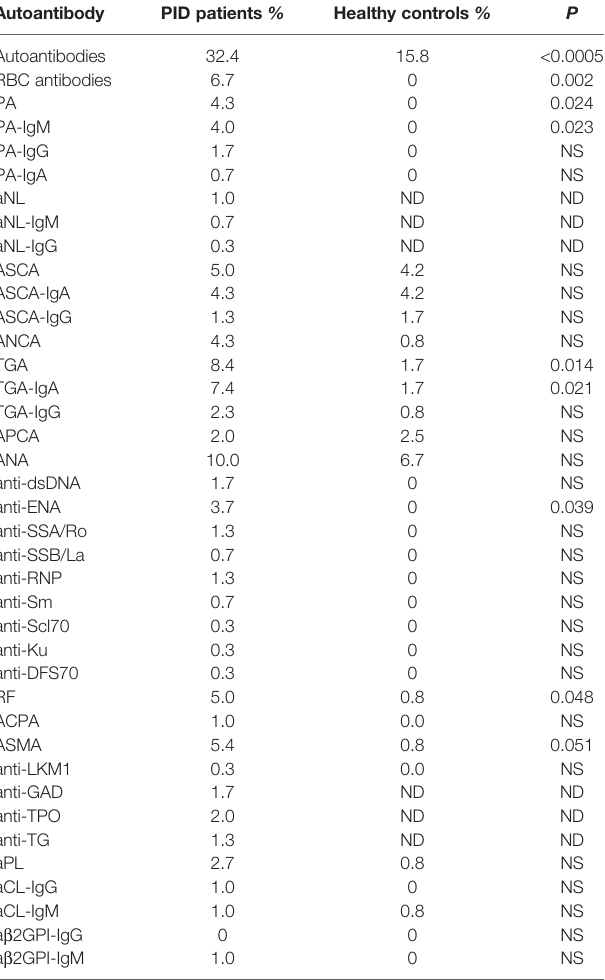
ACPA, anti-citrullinated protein antibody; aCL, anti-cardiolipin antibodies; a b 2GPI, anti- b 2 glycoprotein I antibodies; ANA, anti-nuclear antibodies; ANCA, anti-neutrophil cytoplasmic antibodies; aNL, anti-neutrophil antibody; APCA, anti-parietal cell antibody; aPL,antiphospholipidantibodies;ASCA,anti-saccharomycescerevisiaeantibody;ASMA, anti-smooth muscle antibody; GAD, anti-glutamic acid decarboxylase, LKM, liver-kidney microsome; ND, not determined; NS: not signi fi cant; PA, platelet-bound antibodies; RBC, red blood cell; RF, rheumatoid factor; TG, thyroglobulin; TGA, anti-transglutaminase antibody; TPO, thyroid